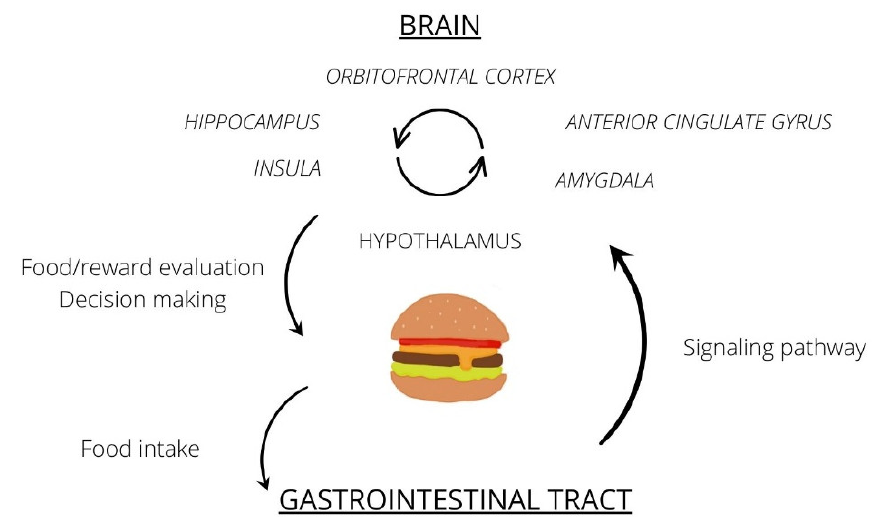
Figure 1. Circulation of food stimuli and engaged brain regions—simplified